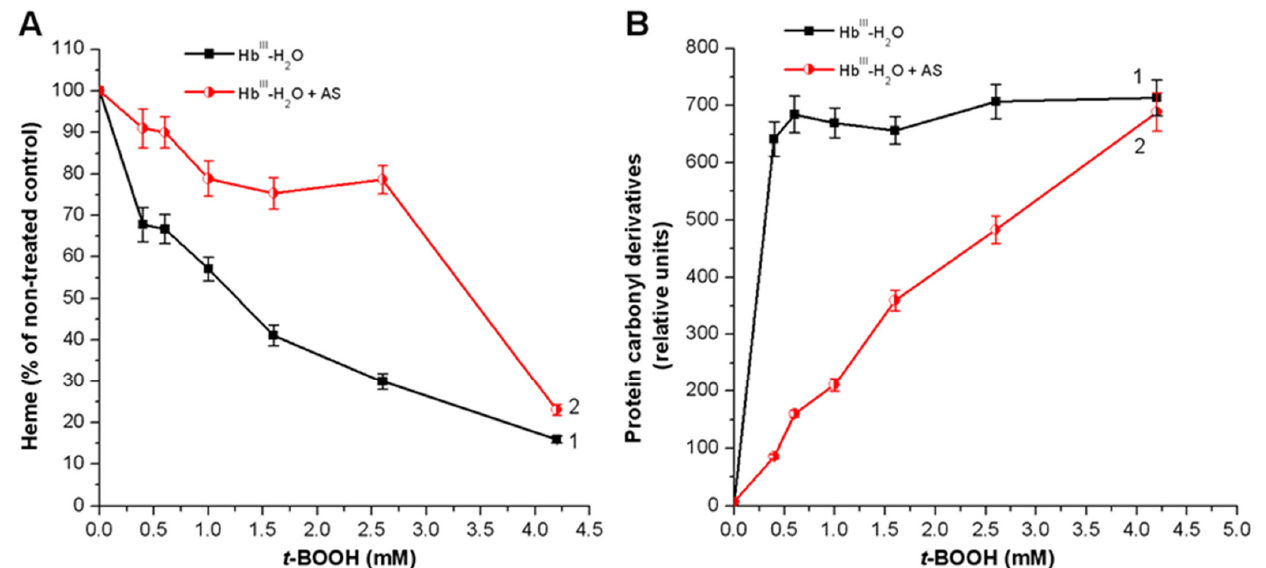
Figure 5. Effect of Angeli’s salt on heme group destruction ( A ) and formation of carbonyl groups on metHb ‐ H 2 O; ( B ) under the influence of various t ‐ BOOH concentrations. Control, without Angeli’s salt (1), with Angeli’s salt (2). Reaction mixture: 0.15 mM metHb ‐ H 2 O in 100 mM PBS (pH 7.4), 2 mM Angeli’s salt. Results are depicted as the mean with S.E.M. of three independent experiments ( n = 3). Student t ‐ test ( А ) ( p ≤ 0.05), student t ‐ test ( В ) ( p ≤ 0.05 for all point except 4.25 mM t ‐ BOOH, for this point, non ‐ significant).